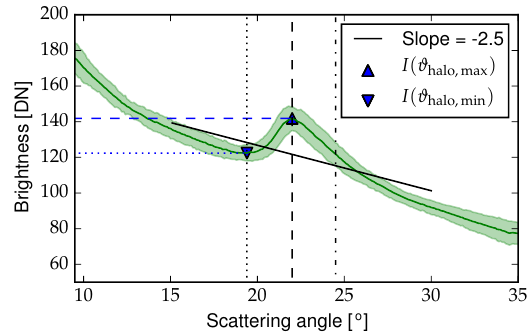
Figure 7. As Fig. 5, showing the first minimum (dotted) and the maximum (dashed) of the 22 ◦ halo for the green channel. In addi- tion, ϑ halo,end is indicated (dash-dotted line), which represents the scattering angle of the same brightness as ϑ halo,min and confines the halo peak. In this example ϑ halo,end is located at about 24.5 ◦ . The corresponding brightness values I(ϑ halo,min ) and I(ϑ halo,max ) used to calculate the HR are marked with blue triangles pointing down (min) and up (max). The regression line of the averaged brightness distribution (solid black), which is evaluated between scattering angles of 15 and 30 ◦ , has a slope of − 2.5 for this ex-